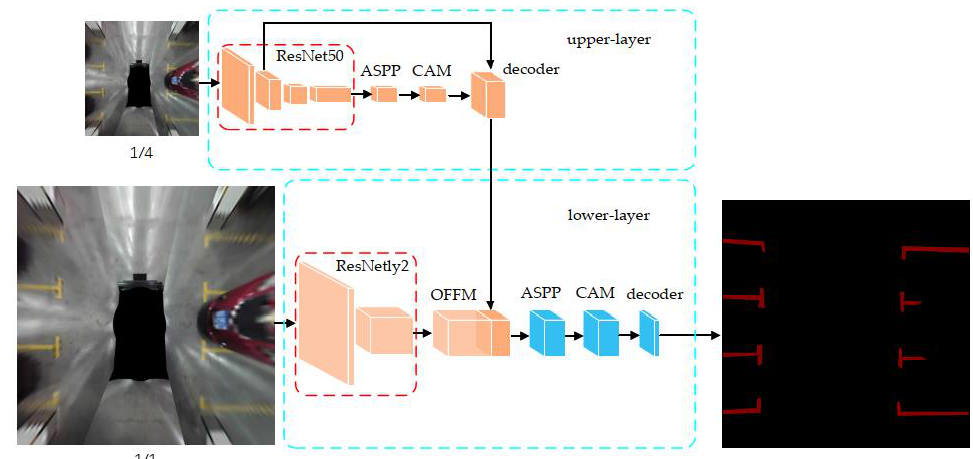
Figure 2. The overall structure of the RPSD network. The network is composed of two layers and the blue dashed boxes in the figure mark the respective parts of the two layers. The red wireframe represents the backbones, the ResNet50 and the ResNetly2 for the upper and lower layers, respectively. The figure shows the 1/4 input image and full-size input image for the upper and lower layers and the inferred full-size output image.